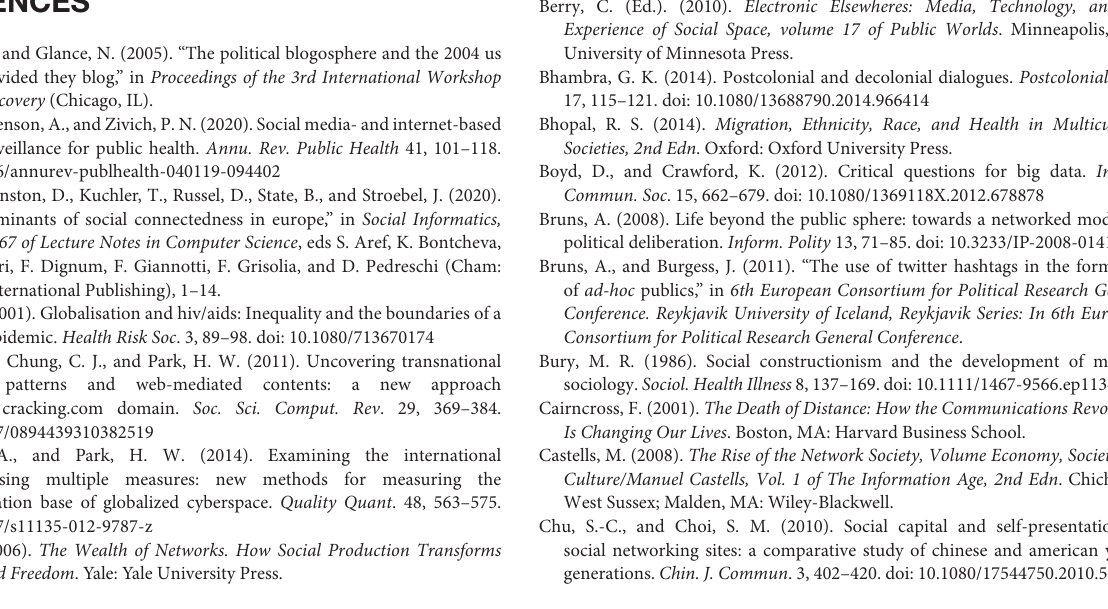
Supplementary Figure 1 | Stringency of measures and transnational share of meta paths on a monthly comparison. Colors describe mean (red points and lines) and median (blue points and lines). Linetype and shape are used to differ between stringency index (dotted) and transnational share (solid). Supplementary Figure 2 | Country-wise development of stringency index. The lines shows the index development per country, facetted by month. Supplementary Figure 3 | Mean number of entities per tweet by country for all indicator (top subfigure) and facetted by entity type (bottom subfigure). Supplementary Table 1 | Sum of meta paths per Type and